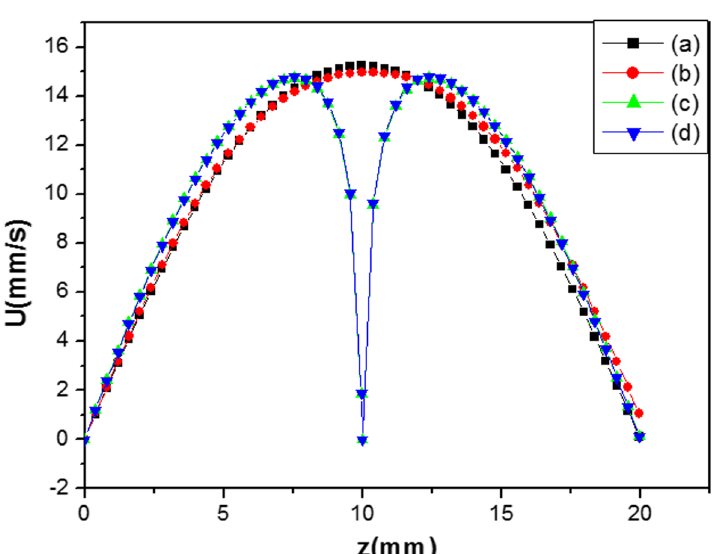
Fig. 4 Distribution of U as a function of z , between filaments for n n 3 ( c ) and for n =